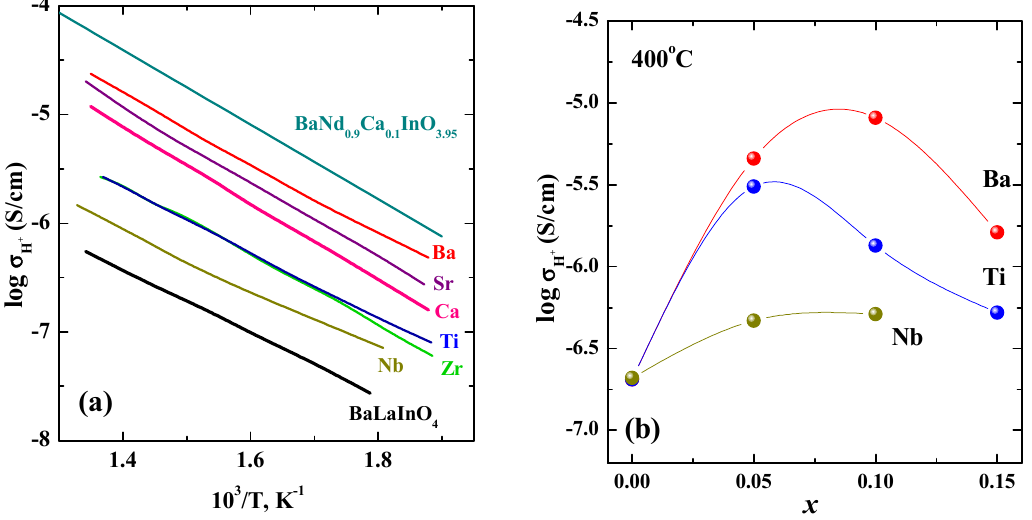
Figure 17. The temperatures dependencies of protonic conductivities for the compositions BaLaInO 4 [76], BaLa 0.9 Ca 0.1 InO 3.95 (Ca) [74], BaLa 0.9 Sr 0.1 InO 3.95 (Sr) [74], Ba 1.1 La 0.9 InO 3.95 (Ba) [74], BaLaIn 0.9 Ti 0.1 O 4.05 (Ti) [78], BaLaIn 0.9 Zr 0.1 O 4.05 (Zr) [78], BaLaIn 0.9 Nb 0.1 O 4.10 (Nb) [84], BaNd 0.9 Ca 0.1 InO 3.95 [82] ( a ); and the concentration dependencies of protonic conductivities for the solid solutions Ba 1+ x La 1 − x InO 4 − 0.5 x (red) [79], BaLaIn 1 − x Ti x O 4+0.5 x (blue) [80] and BaLaIn 1 − x Nb x O 4+ x (dark yellow) ( b ) [84].